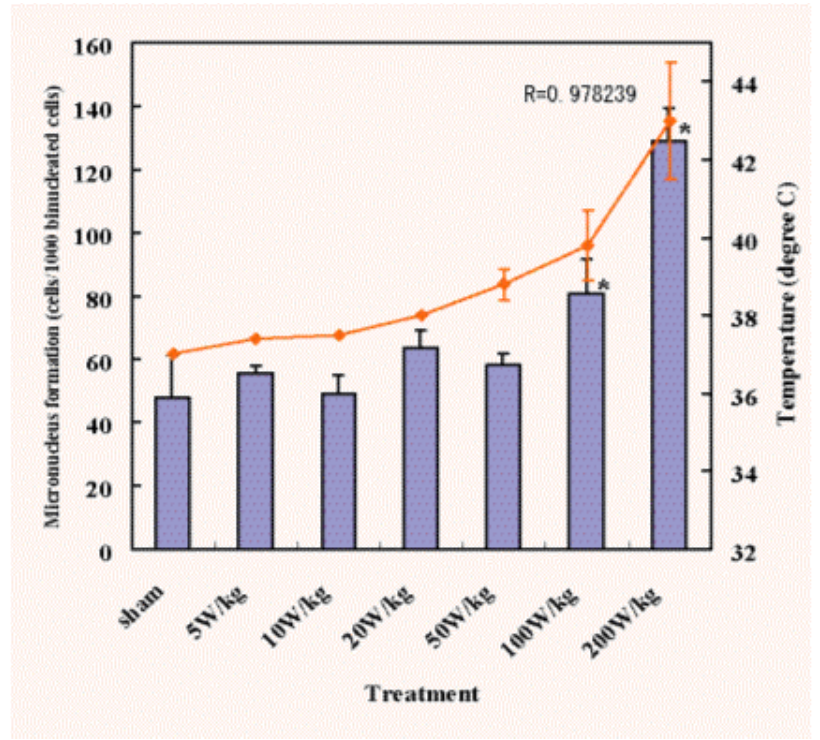
FIGURE 9 . The relationship between the effect of exposure to HFEMF and temperature. Columns indicate the means of MN frequency and the line graph indicates the change in temperature generated by exposure to HFEMF. The bars represent standard deviations from three experiments. There were no temperature changes on sham exposure or HFEMF exposure at SARs of 5, 10, 20, and 50 W/kg. An asterisk indicates a statistically significant difference between sham exposure and HFEMF exposure ( p < 0.01). R represents the correlation coefficient between the frequency of MN formation and